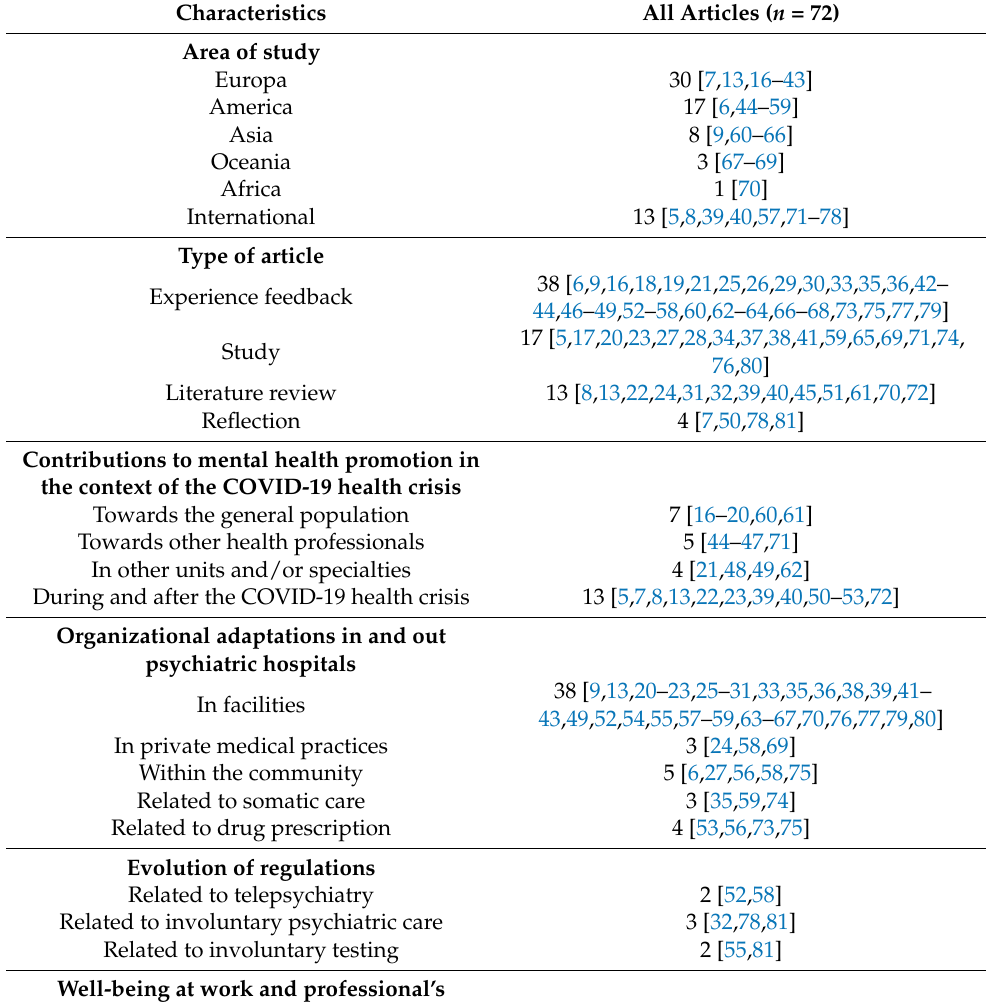
Table 3. Information about the selected